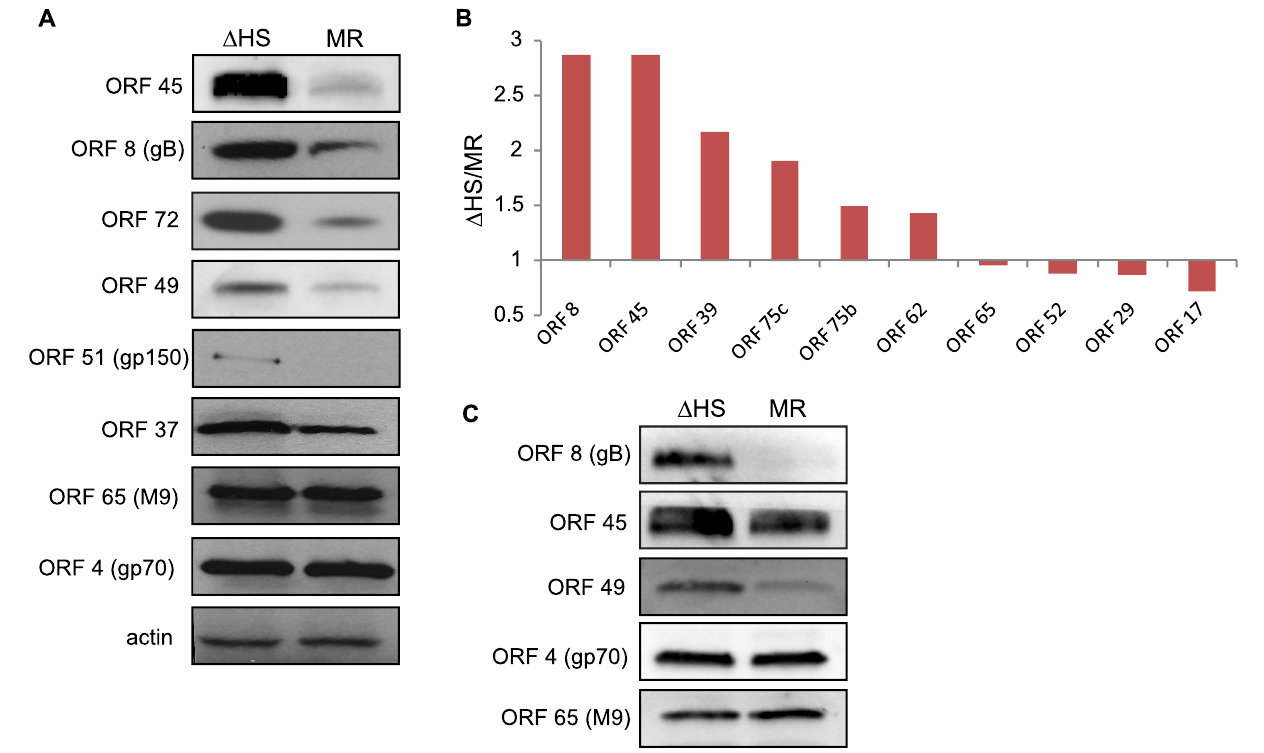
Figure 3. RNA degradation alters intracellular viral protein levels and virion composition. (A) To compare the accumulation of viral proteins during infection with D HS and MR MHV68, NIH 3T3 cells were infected at MOI of 5 and cell lysates collected at 24 hpi. Viral proteins were detected using antibodies against ORF 45, 8, 72, 49, 51, 37, 65, and 4. Actin was used as a loading control. (B) Relative abundance of some virion proteins comparing D HS levels over MR based on mass spectrometry (MS) peptide counts. Virions were isolated by sucrose gradient centrifugation and run through MS. Peptide numbers were normalized to major capsid ORF 25 and genome number as determined by qPCR. Graph includes data from two independent MS runs. (C) Virions were isolated by sucrose gradient centrifugation and abundance of the virion proteins ORF 8, 45, 49, 4, and 65 were determined by Western blot.